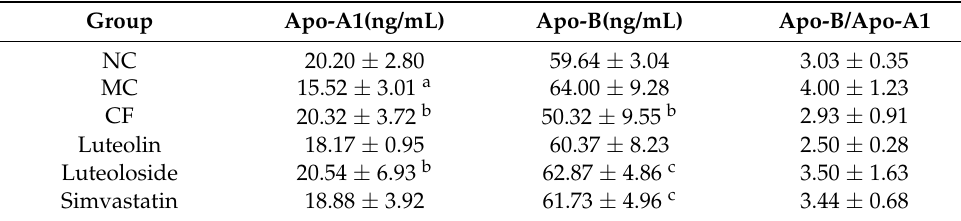
Table 6. Changes of Apo-A1, Apo-B, and Apo-B/Apo-A1 in SD rats of each group.